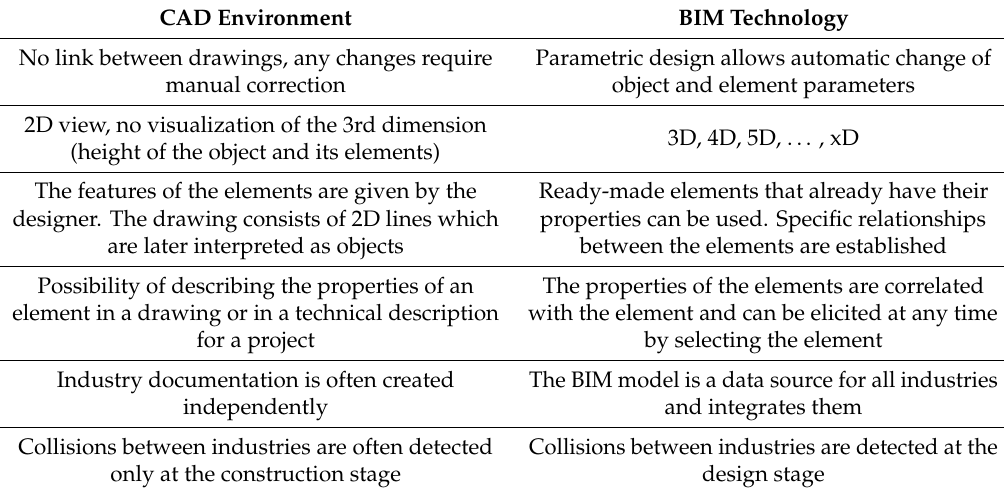
Table 1. Comparison of CAD and BIM software capabilities (own